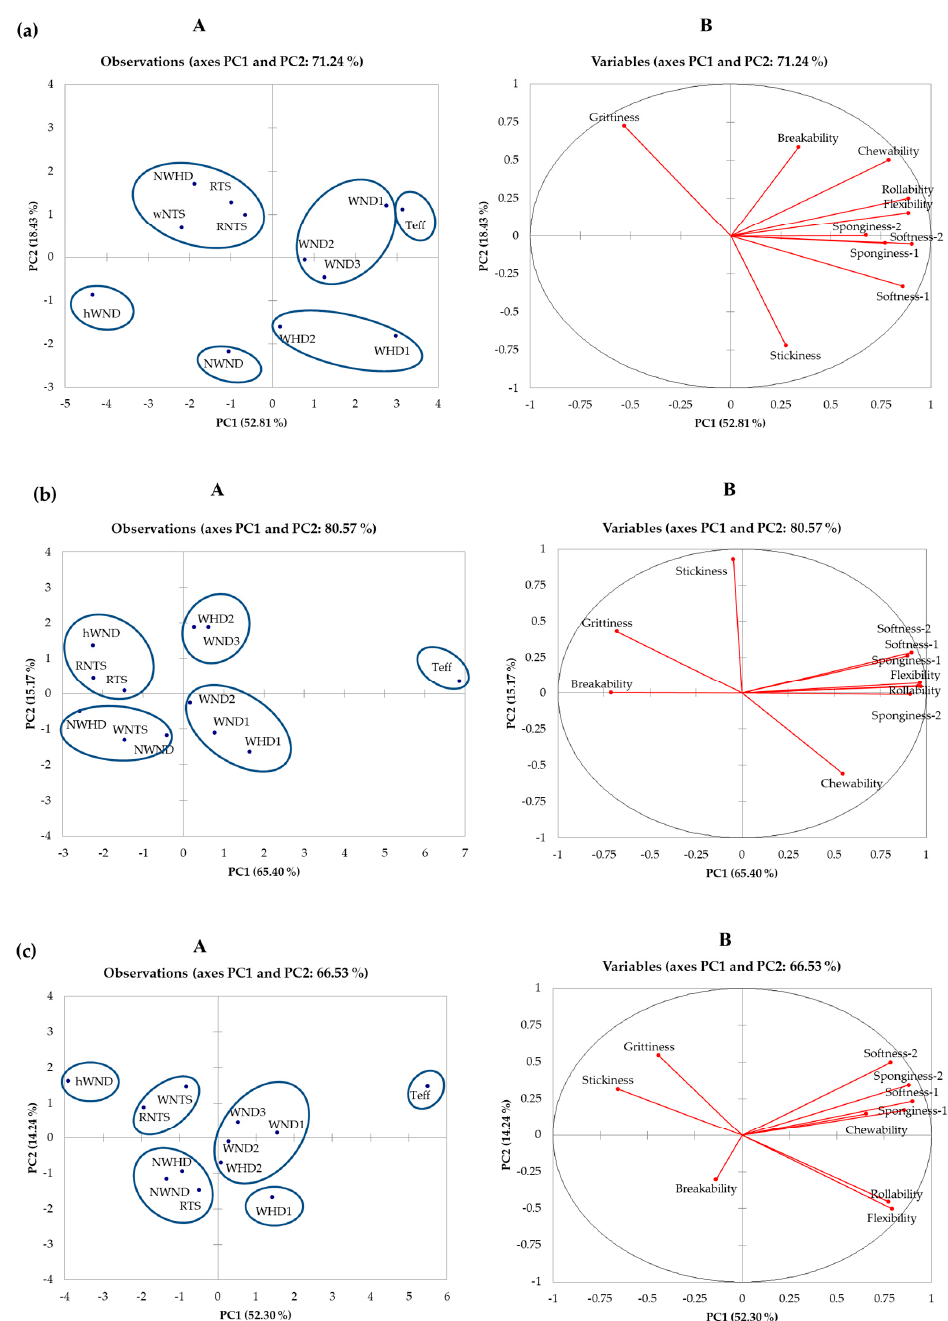
Figure 3. PCA of novel sorghum lines, normal sorghum types, and te ff and their injera textural quality attributes of ( a ) freshly prepared injera, ( b ) stored injera (2 days at 5 ◦ C), ( c ) stored injera (4 days at 5 ◦ C); ( A ) Sorghum line PC scores. NWND, non-waxy-normal protein digestibility; NWHD, non-waxy-high protein digestibility; hWND, heterowaxy-normal protein digestibility; WND1, WND2, and WND3, waxy-normal protein digestibility lines 1, 2, and 3; WHD1 and WHD2, waxy-high protein digestibility lines 1 and 2; wNTS, white non-tannin sorghum; RNTS, red non-tannin sorghum; RTS, red tannin sorghum; ( B ) Textural attribute PC loadings. Softness-1 (by hand touch), softness-2 (in-mouth sensation), flexibility, rollability, stickiness, sponginess-1 (by hand), sponginess-2 (in-mouth), chewiness, breakability, and